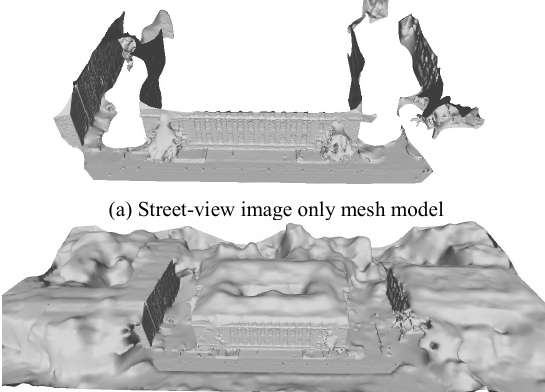
(a) Street-view image only texture mapping